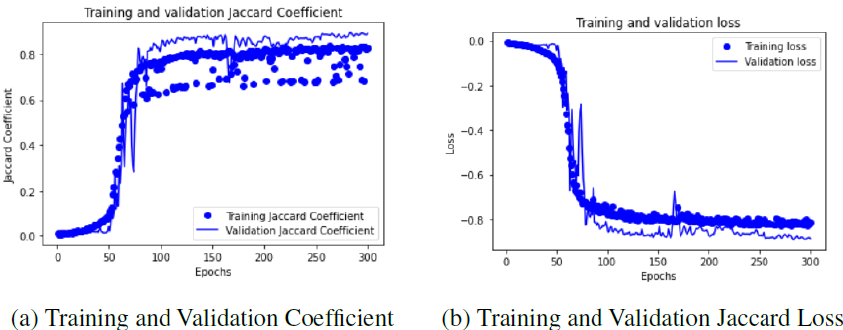
Figure A10. JL training and validation curves after 300